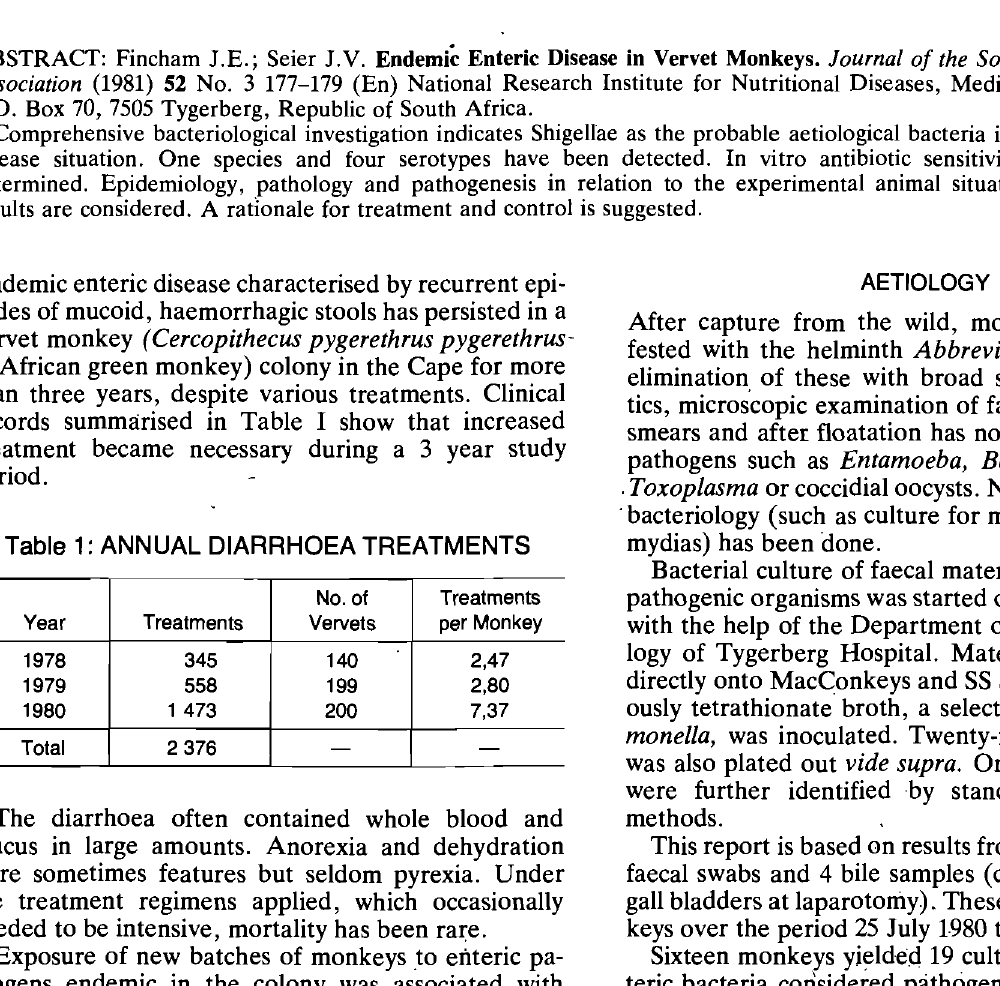
Table 2: INDIVIDUAL RECORDS OF DIARRHOEA EPI$ODES